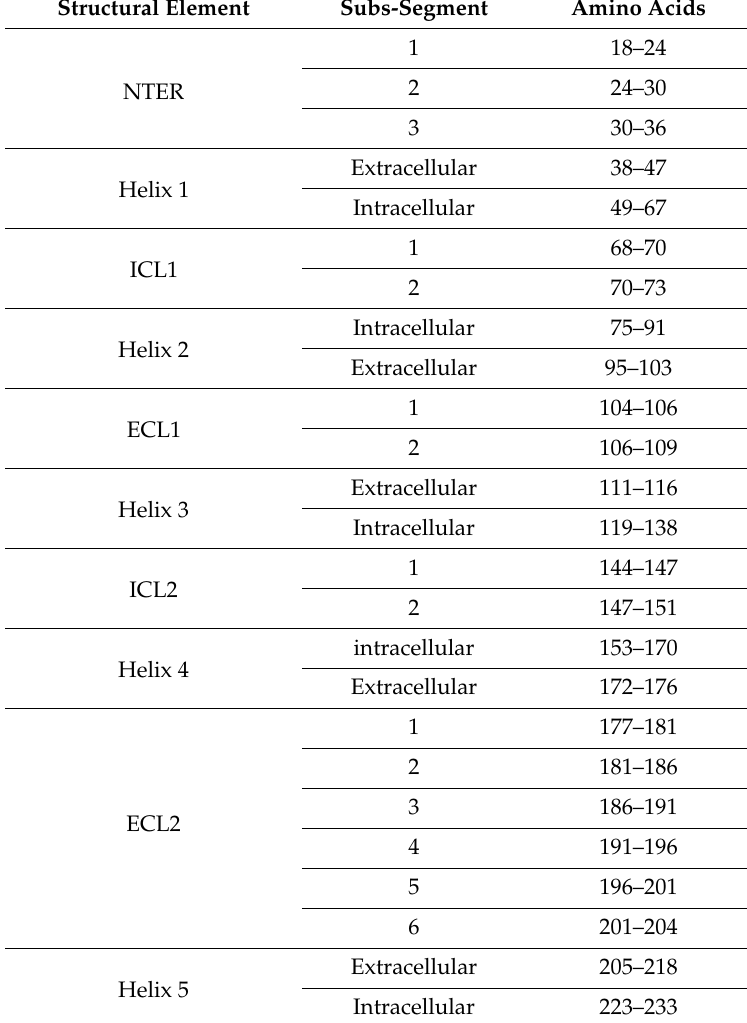
Table 3. Summary of the amino acids that comprise the individual segments used in the analysis of the MD